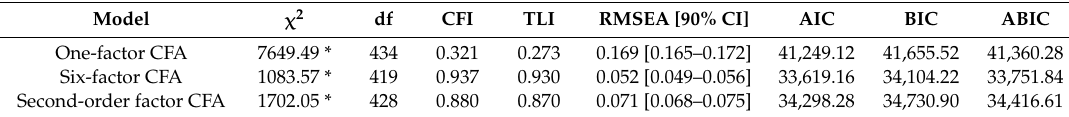
Table 2. Goodness-of-Fit